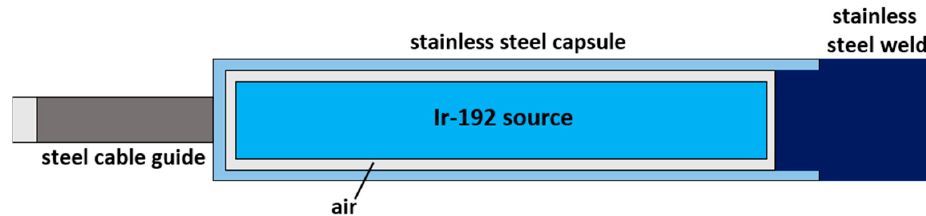
Figure 2. Schematic representation of the Iridium-192 Flexisource (adapted from Granero et al. [58]). The Ir-192 core is 3.50 mm long and has a diameter of 0.60 mm.